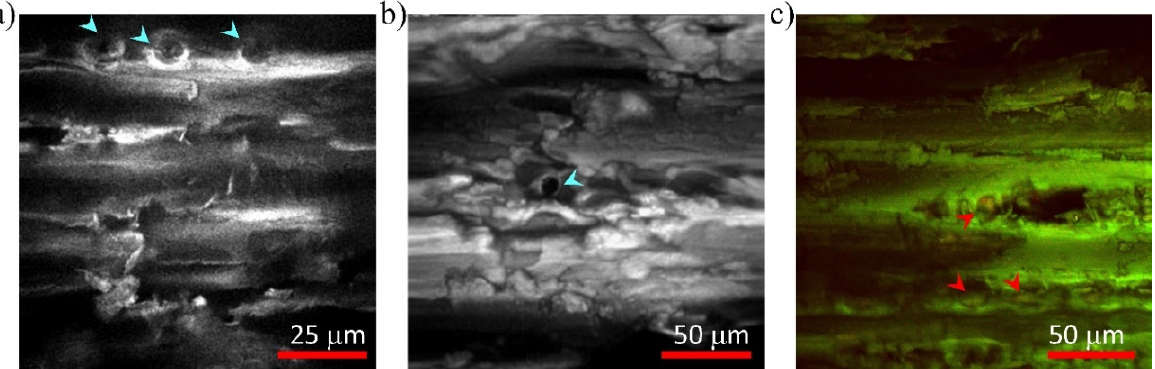
Figure 2. NLO microscopy images of poplar shavings cut along the direction of the stem on the tangential plane (excitation wavelength 840 nm). Bordered pits are pointed out by light-blue arrowheads. Greyscale intensity images ( a ) 100 × 100 μ m 2 and ( b ) 200 × 200 μ m 2 are obtained by optically summing all excited nonlinear signals, thus showing both SHG and TPEF signals indistinctively. ( c ) TPEF/SHG merged image (200 × 200 μ m 2 ) enabling the distinction between TPEF (green-coded) and SHG (red-coded) signals, attributed to lignin and starch (pointed out by the red arrowheads), respectively.